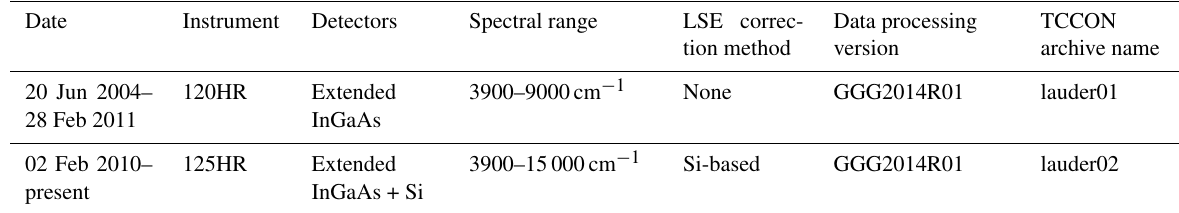
Table 1. Instrument